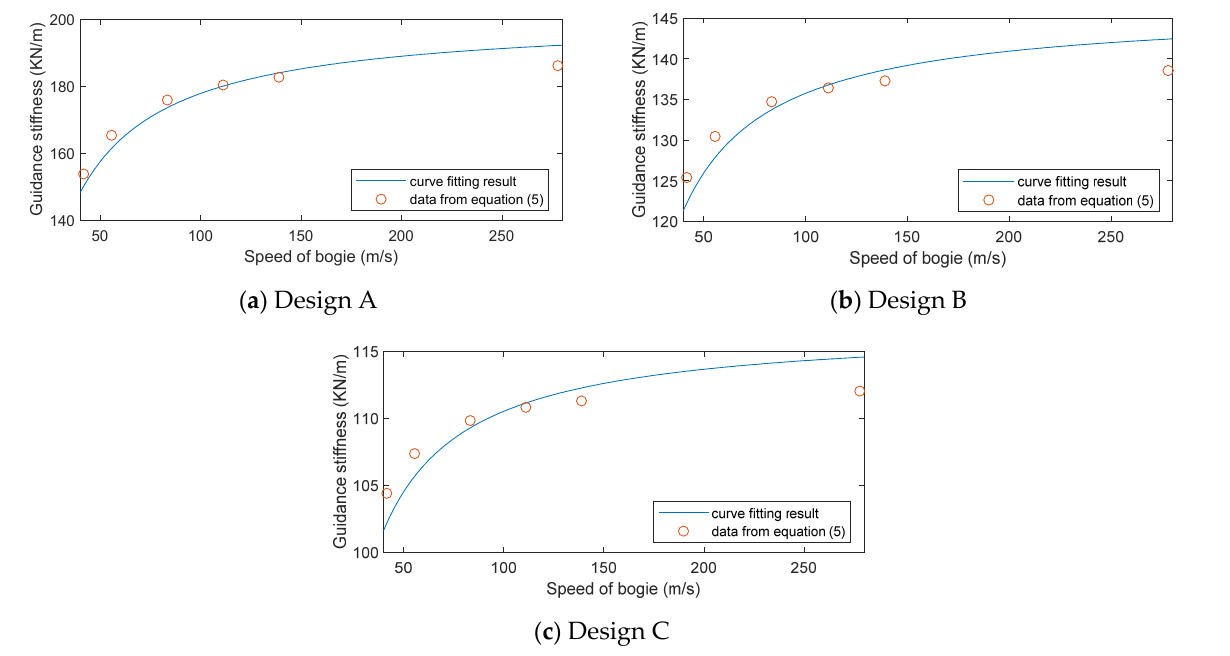
Figure 11. Guidance stiffness with respect to the speed of the traveling body.